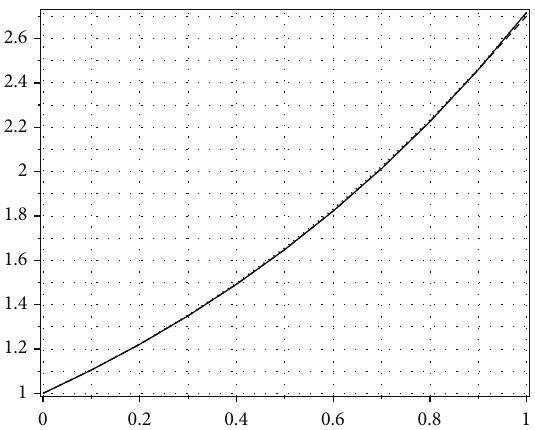
Figure 2: Comparison of the analytic and approximate solution of Example 2 by proposed algorithm and [3]. In this figure solid line shows exact solution, dotted lines show approximate solution by proposed algorithm, and dashed lines show the solution obtained by [3].